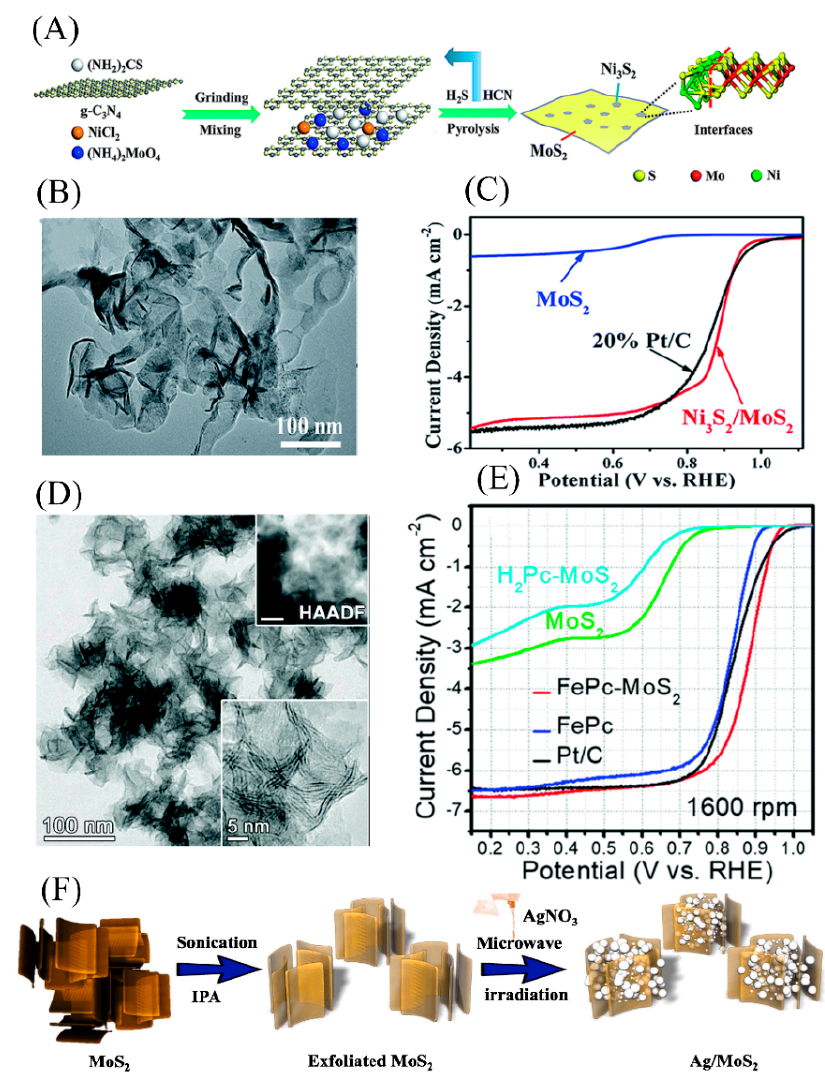
Figure 13. ( A ) Proposed synthetic protocol for ultrathin Ni 3 S 2 /MoS 2 nanosheets. ( B ) TEM image of Ni 3 S 2 /MoS 2 -0.2 nanosheets. ( C ) Electrochemical evaluation of catalysts in alkaline media. Repro- duced with permission from [107] Copyright © 2021 The Royal Society of Chemistry. ( D ) HRTEM and HAAD-STEM images of the FePc-MoS 2 hybrid complex. ( E ) Electrochemical evaluation of catalysts of FePc-MoS 2 in alkaline media. Reproduced with permission from [108] Copyright © 2021 The Royal Society of Chemistry. ( F ) Representation of synthetic procedure of a Ag/MoS 2 nanohybrid. Reproduced with permission from [110] Copyright © 2021 Elsevier